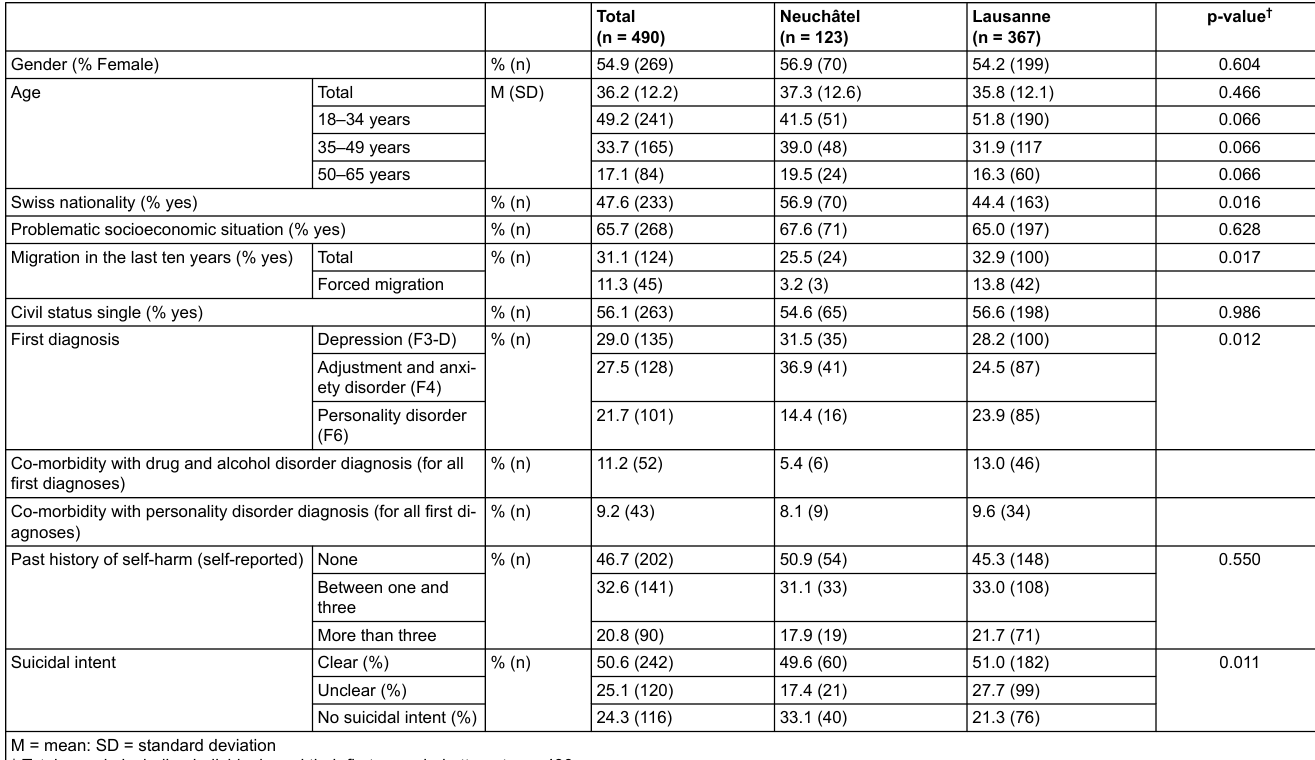
Table 4: Characteristics of the sample * and variable description by